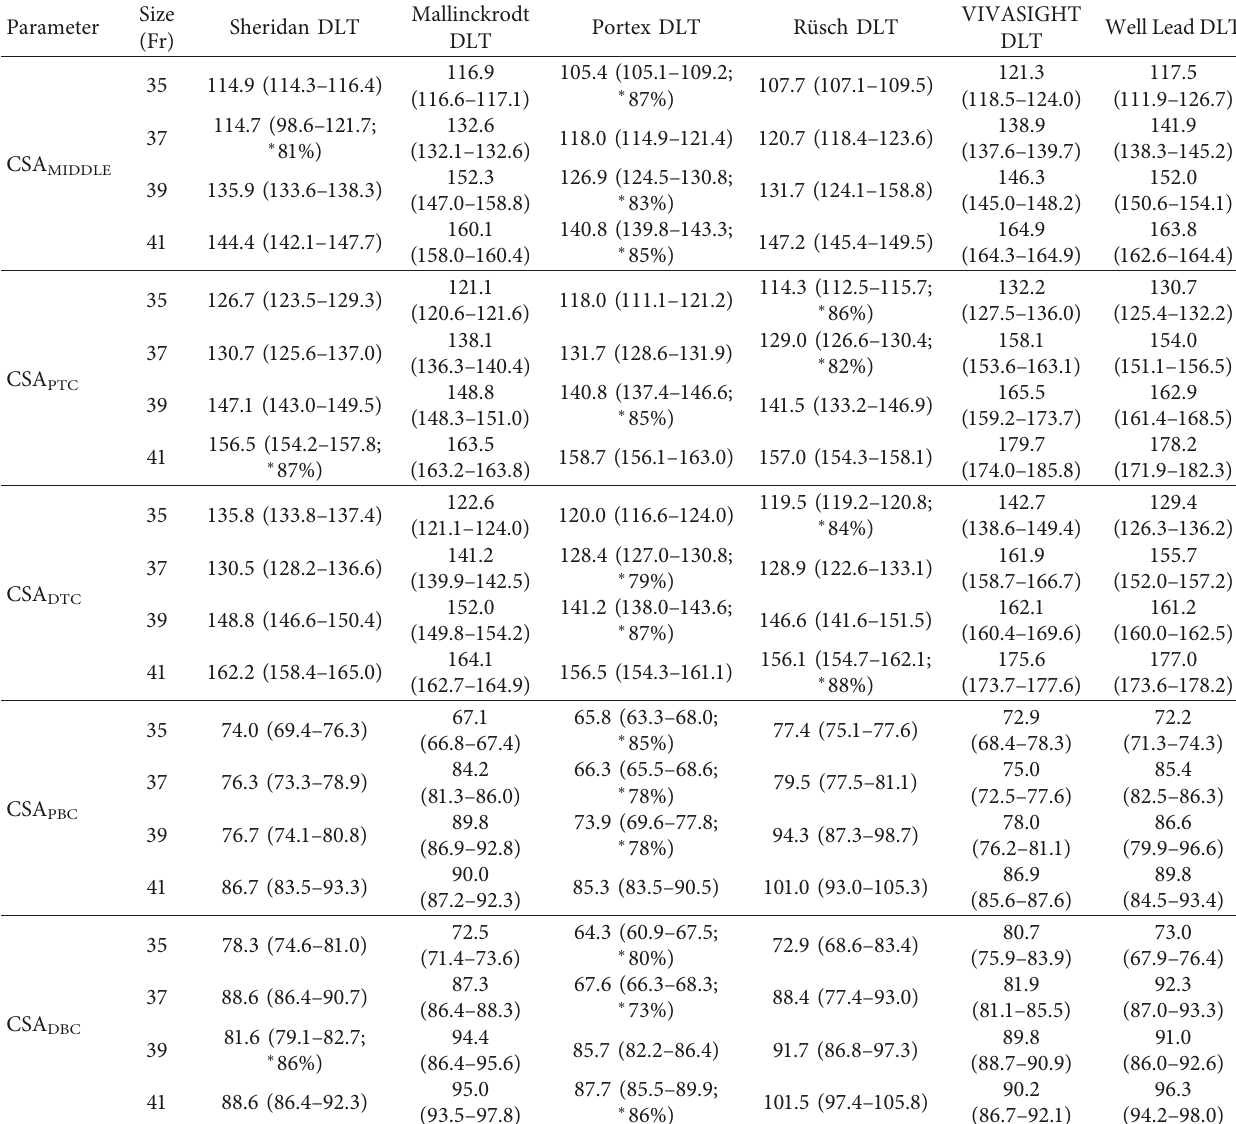
Table 3: Calculated cross-sectional areas (CSAs) of investigated left-sided double-lumen endobronchial tubes (DLTs) based on mea- surements expressed in Table